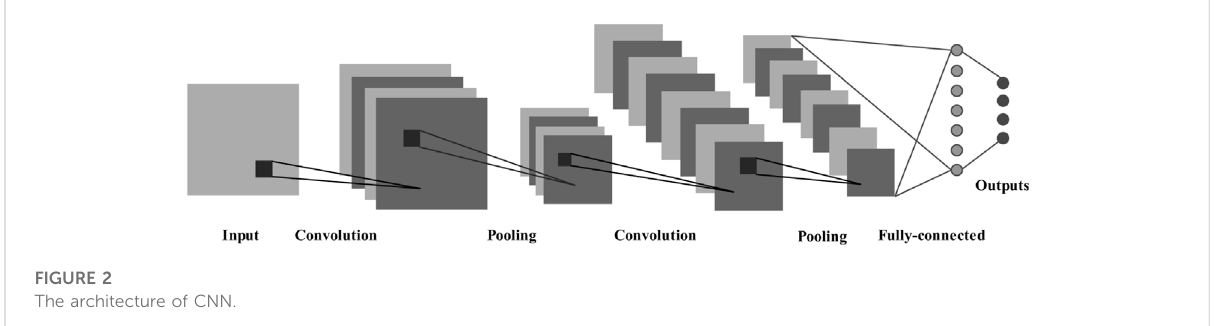
FIGURE 2 The architecture of CNN.